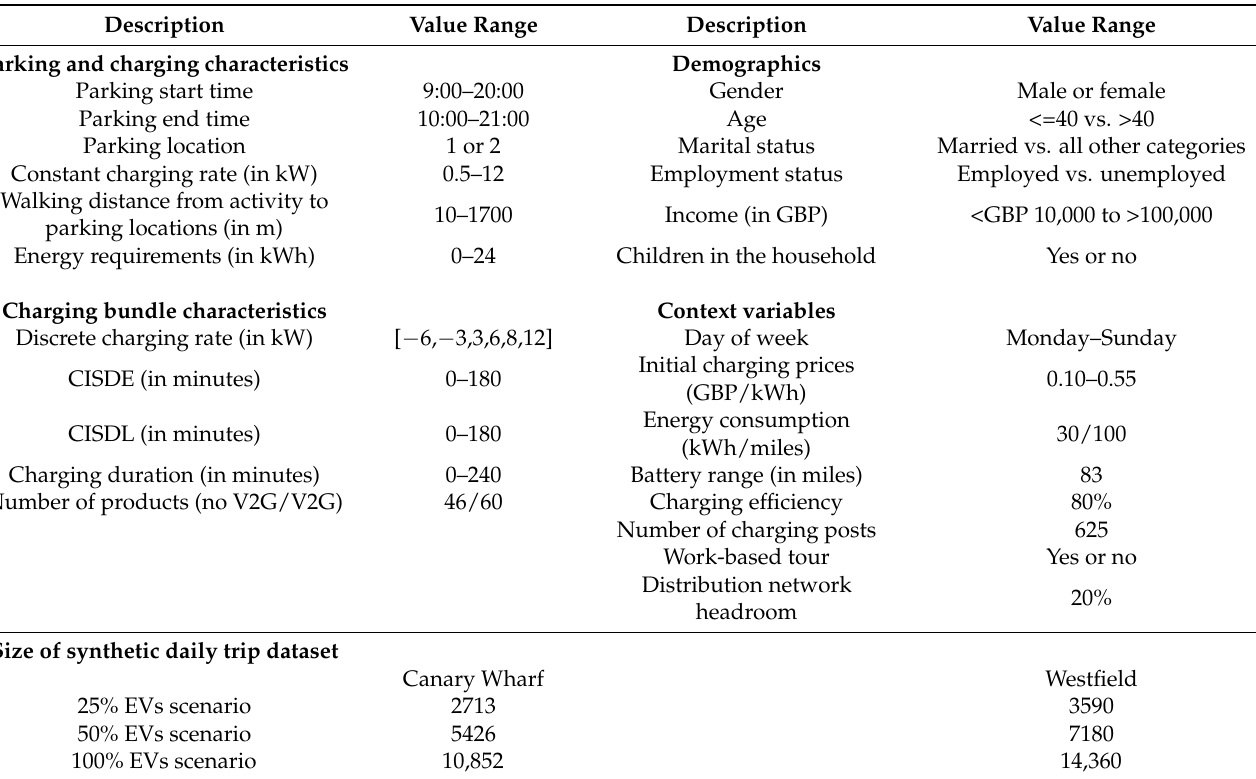
Table 1. Description of the input data used in the